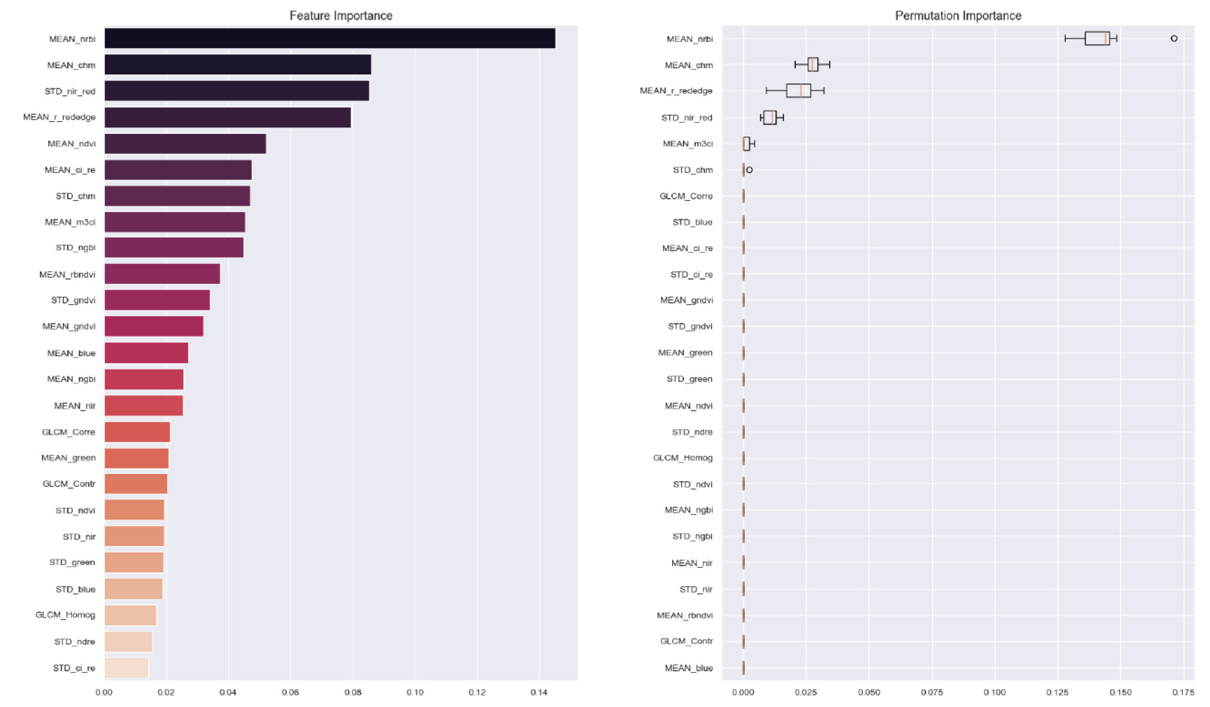
Figure 7. Feature and Permutation Importance at superpixel scale with Euc spp. aggregated. Features relevant were the same in both approaches (VIs and CHM). Based on random permutation of features, fewer features were relevant for the model.